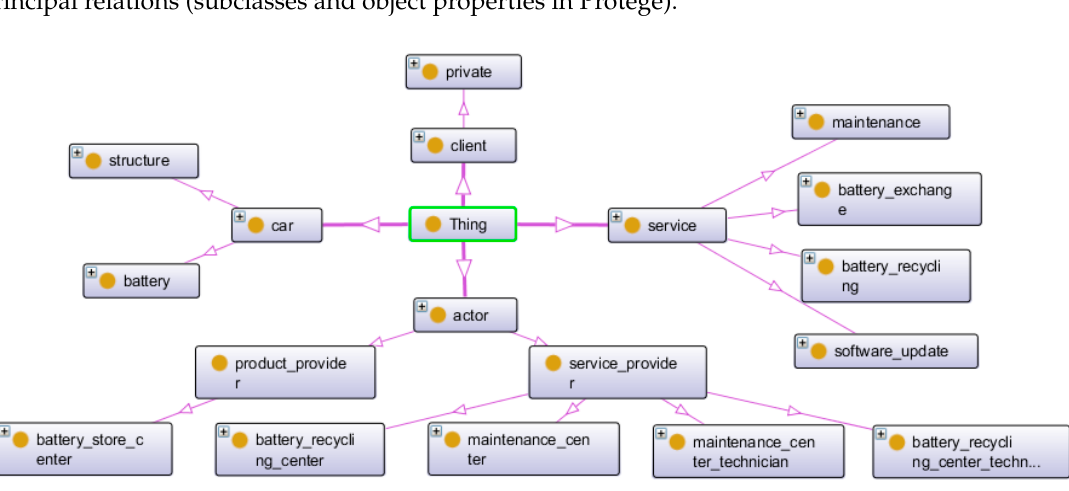
Figure 7. Overview of the domain-specific ontology of EV service.